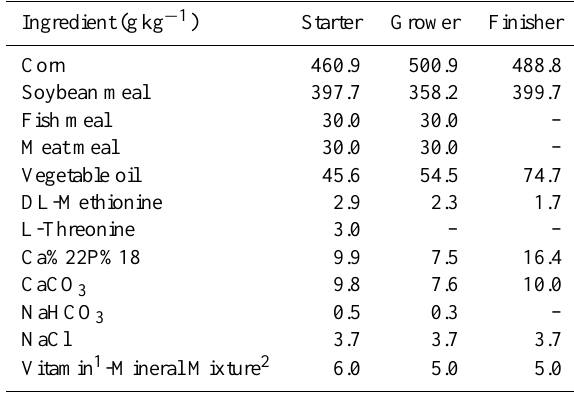
Table 2. Nutrient composition of diets fed to